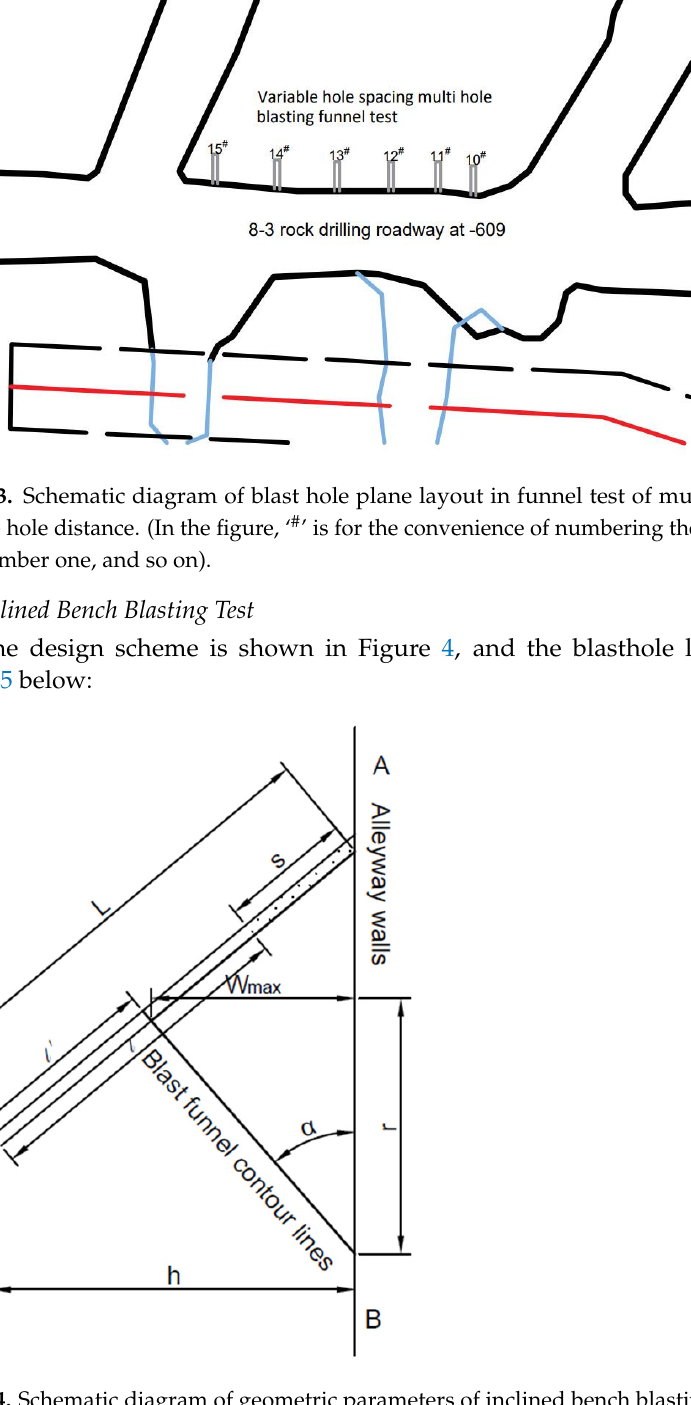
Figure 4. Schematic diagram of geometric parameters of inclined bench blasting.